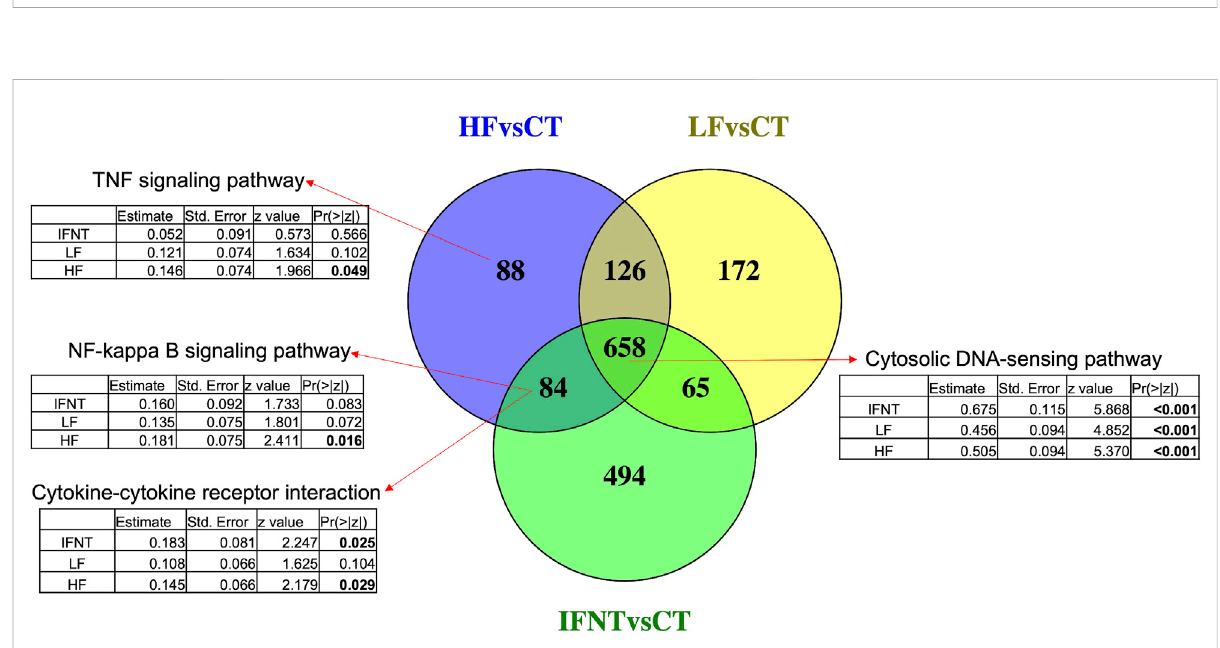
FIGURE 4 Venn Diagram of the differentially expressed genes between each group and the Control. Overlapping genes between the three comparisons enriched IFN-production pathways, such as cytosolic DNA-sensing. The other arrows indicate the enriched pathways by the corresponding genes. Below each pathway are shown the coef fi cients for the group effect in the expression of all genes in such pathway, modeled by negative binomial regression.Signi fi cant p -valuesareinbold.RNAseqdatafromendometrialexplants exposedtonothing(Control,CT),interferon tau(IFNT),ora Day 15 conceptus from a high fertility (HF) or low fertility (LF)